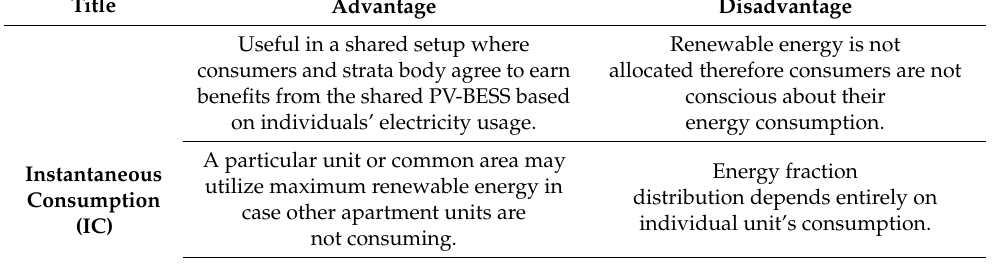
Table 3. Advantages and disadvantages of the three